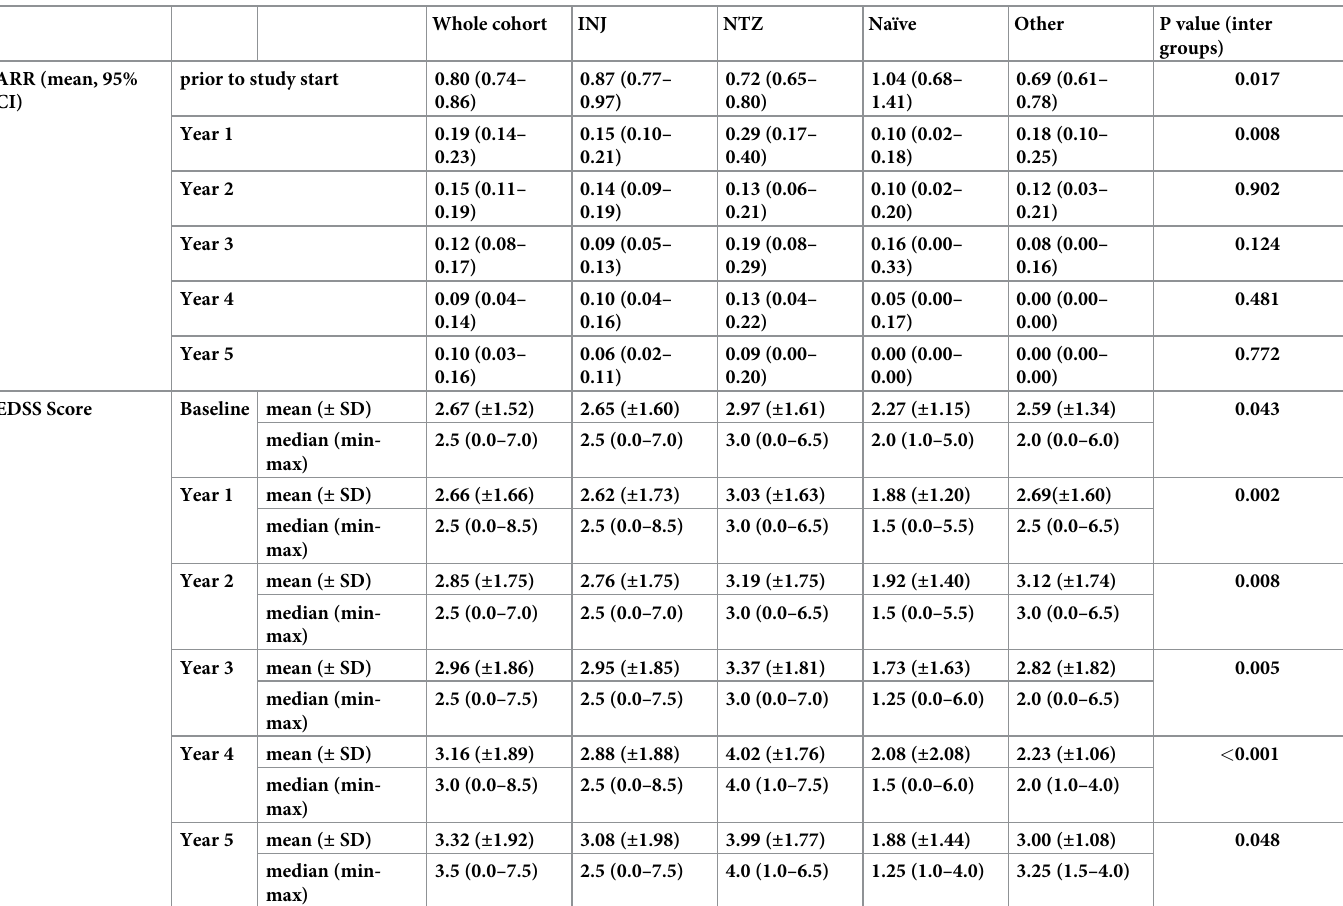
Table 2. Efficacy of fingolimod stratified by previous DMT